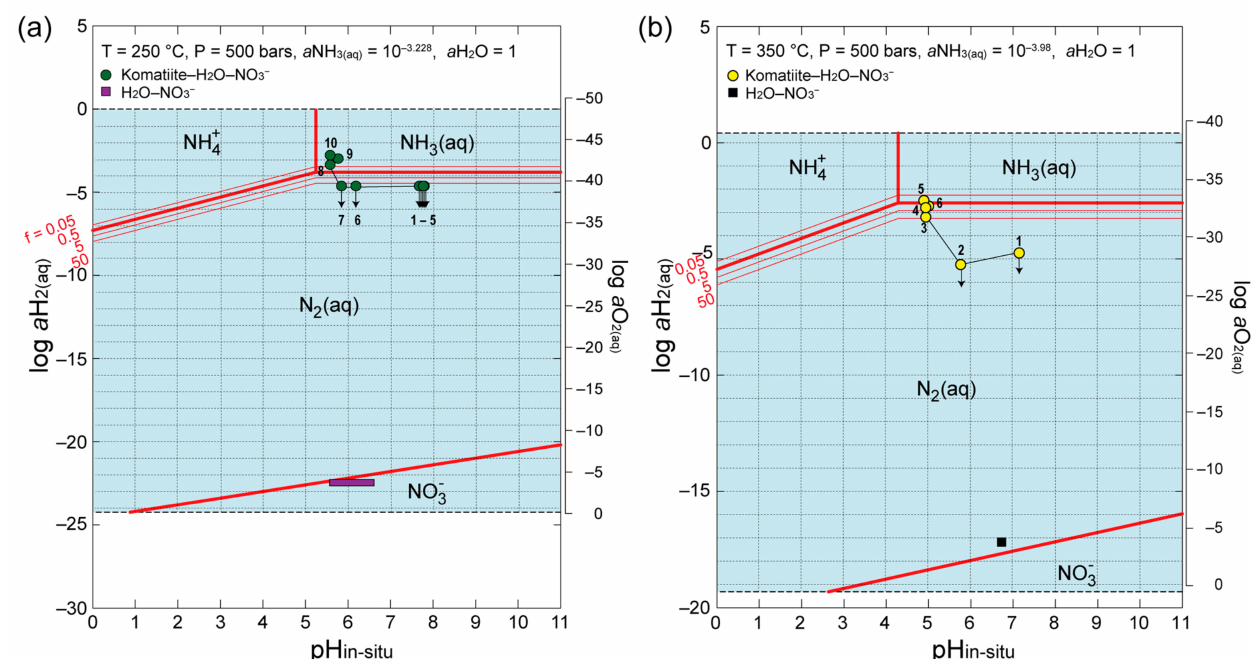
Figure 9. Diagrams of pH in-situ and a H 2(aq) (or a O 2(aq) ) with stability fields of nitrogen species in thermodynamic equi- librium at ( a ) 250 ◦ C and ( b ) 350 ◦ C, 500 bars. Bold red lines indicate the pH in-situ and a H 2(aq) values at which the activ- ity ratios of two nitrogen species follow the relations: a NH 4+ / a NH 3(aq) = 1, a N 2(aq) / a NH 3(aq) = 0.5, a N 2(aq) / a NH 4+ = 0.5, or a N 2(aq) / a NO 3 − = 0.5. For the calculation, a NH 3(aq) values were used in the final sampled fluids at 250 ◦ C and 350 ◦ C ( a NH 3(aq) = 10 − 3.228 and 10 − 3.98 at 250 ◦ C and 350 ◦ C, respectively). Thin, kinked red lines show the pH in-situ and a H 2(aq) values at which the activity ratio of a N 2(aq) /( a NH 3(aq) + a NH 4+ ) is equal to 0.05, 5, and 50. Green and yellow circles indicate the fluid compositions in the komatiite–H 2 O–NO 3– system at 250 ◦ C and 350 ◦ C, respectively. The circles with black arrows imply that a H 2(aq) in the plot is the maximum estimate. Numbers associated with green and yellow circles show sub-name of sampled fluids in experiments N250 and N350, respectively (Table 1). Purple and black boxes denote the fluid compositions in the H 2 O–NO 3– system at 250 ◦ C and 350 ◦ C, respectively (experiments N250C and N350C). Light blue areas in pH in-situ – a H 2(aq) spaces are the stability fields of water at 250 ◦ C and 350 ◦ C,